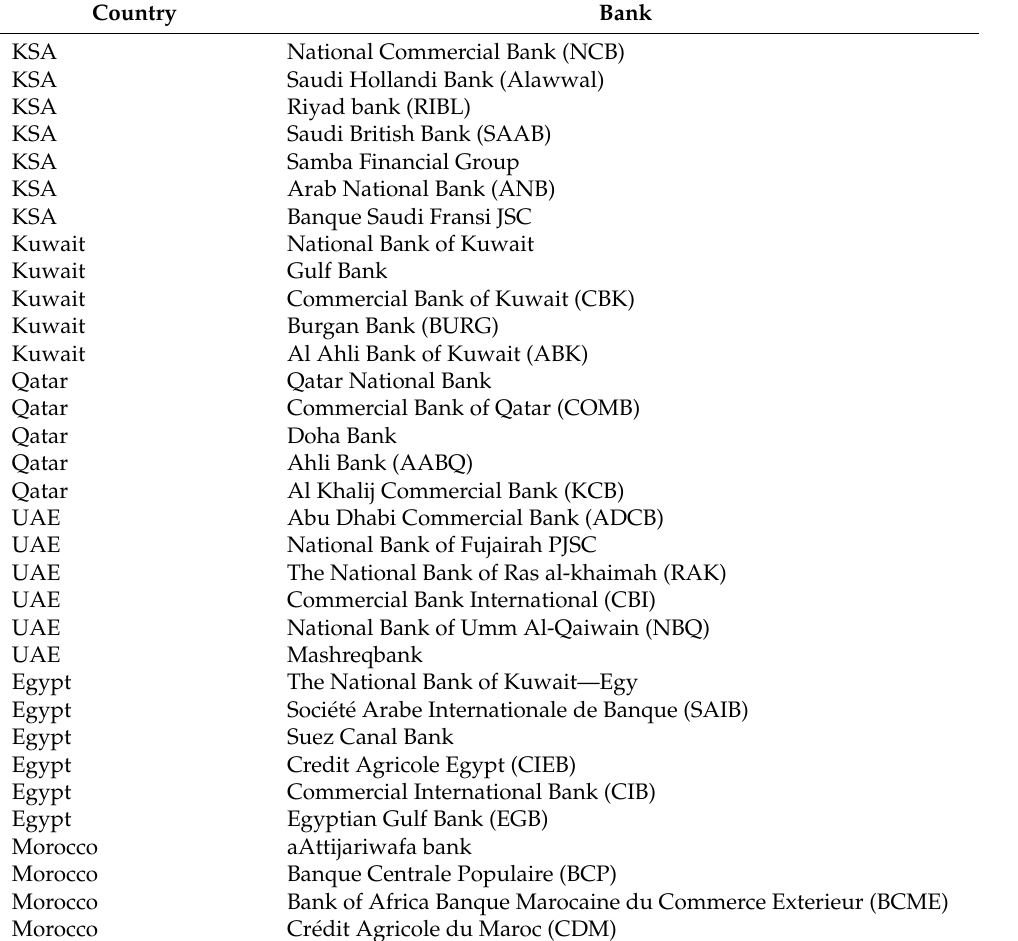
Table A5. List of the banks examined in this